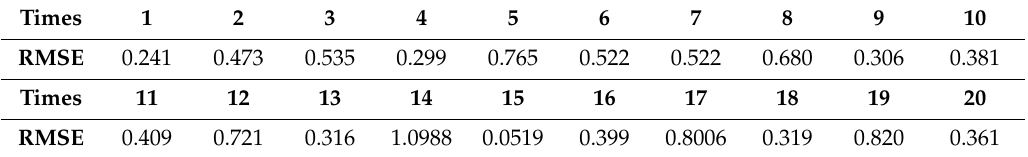
Table 7. Partial RMSE values of hundreds of iteration results by using the IGA-BPNN model.